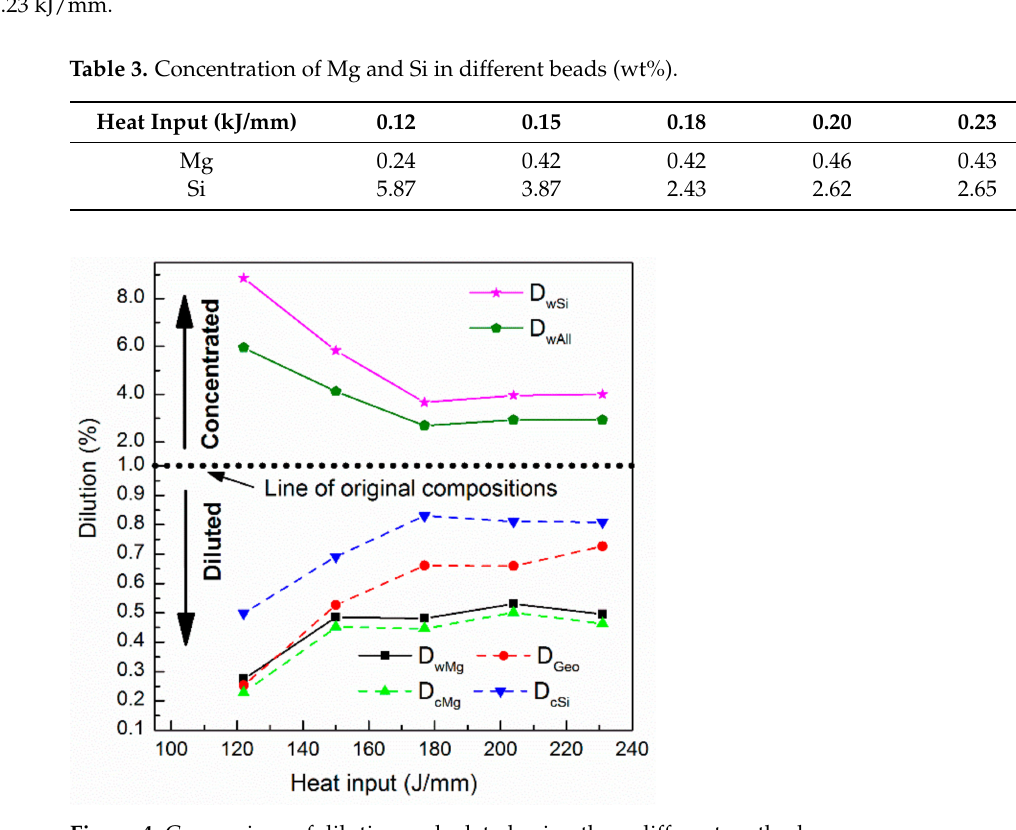
Figure 4. Comparison of dilutions calculated using three different methods. Table 4. Comparison of dilutions calculated using three different